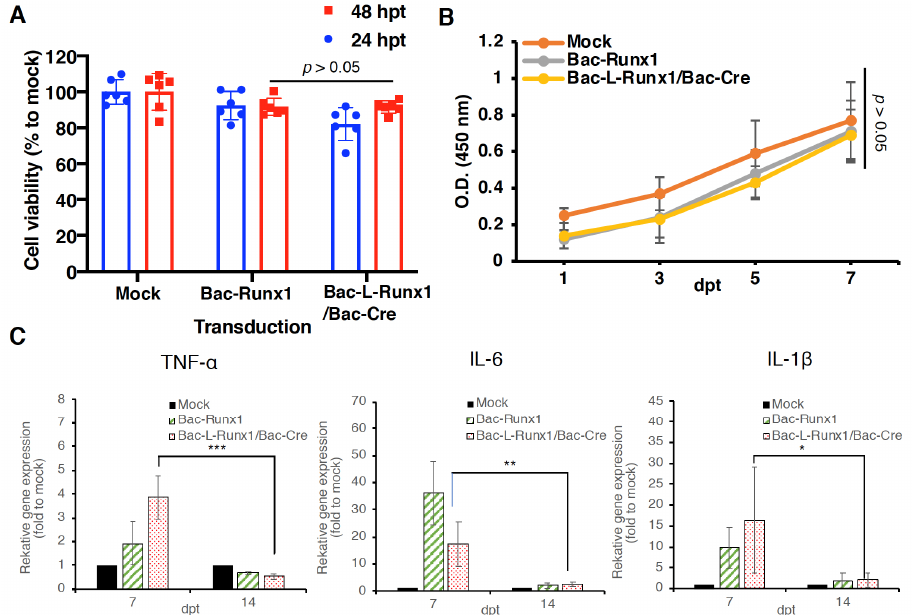
Figure 3. Recombinant BV was sustaining runx1 expression through Cre/LoxP mechanism pos- sessing highly biosafety. ( A ) BMSCs’ viability at post-transduction was examined by MTT assay. ( B ) BMSCs’ proliferation rate at post-transduction was examined by WST-1 assay. ( C ) TNF- α , IL-6 , and IL-1 β mRNA expression at 7- and 14-dpt. ( n ≥ 3) * p < 0.05; ** p < 0.01; *** p <